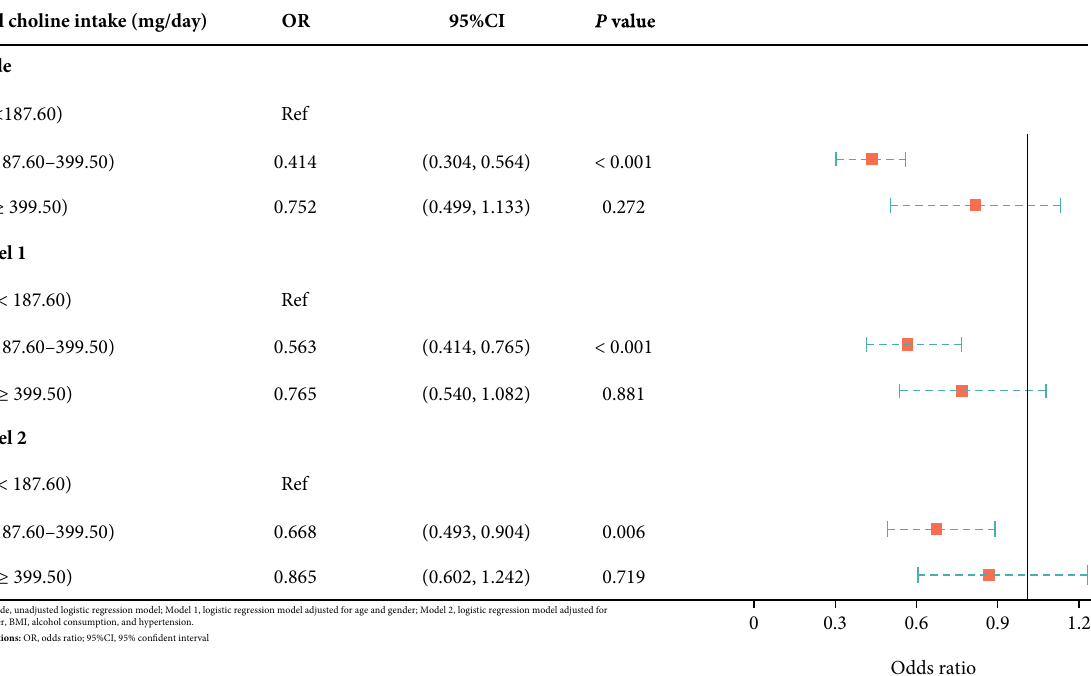
Figure 2: Forest plot-association between choline intake and cognitive performance assessed by the CERAD test. Table 3: The association between choline intake and cognitive performance assessed by the AF test.